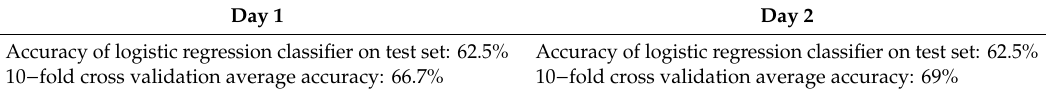
Table 8. Model accuracy on Days 1 and 2, cross validation results, and sensitivity and specificity information.